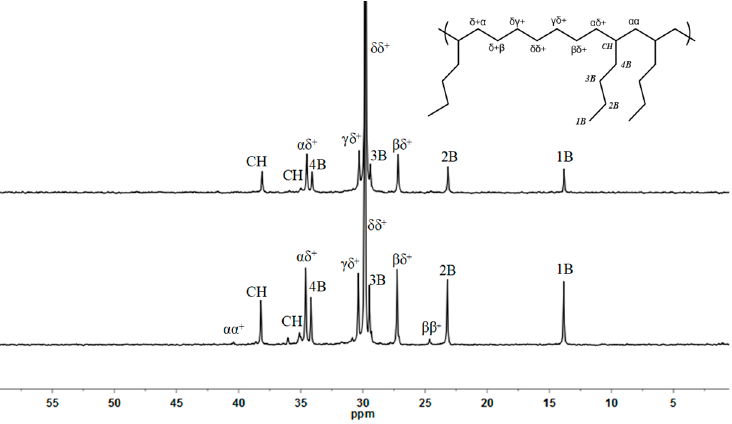
Figure 8. 13 C NMR spectra for ethylene/1-hexene copolymers obtained from entries 11 and 13, Table 2. Table 3. Monomer sequence distributions ethylene/1-hexene copolymers obtained with Ti3 and Ti4 /DMAO system a .